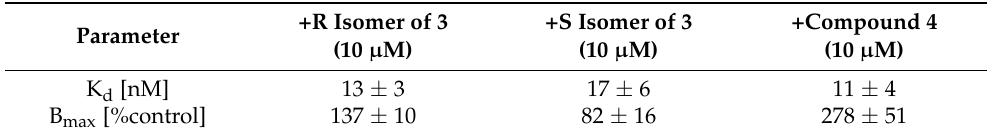
Figure 5. Allosteric modulator 3 and its derivative 3a suggested as a silent allosteric modulator (SAM). Allosteric modulators 4 and 5 . Chiral carbon is indicated with an asterisk. Table 3. Effects of the stereoisomers of compound 3 and compound 4 on the saturation binding of [ 3 H]-dopamine to the human dopamine D 2 receptor. Data are mean 6 standard deviation from three separate experiments [36].